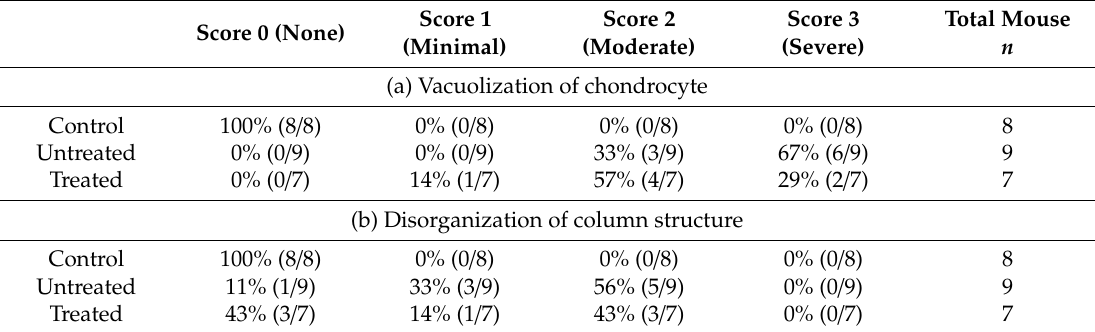
Table 1. Pathological score in growth plate region of femur / tibia of MPS IVA